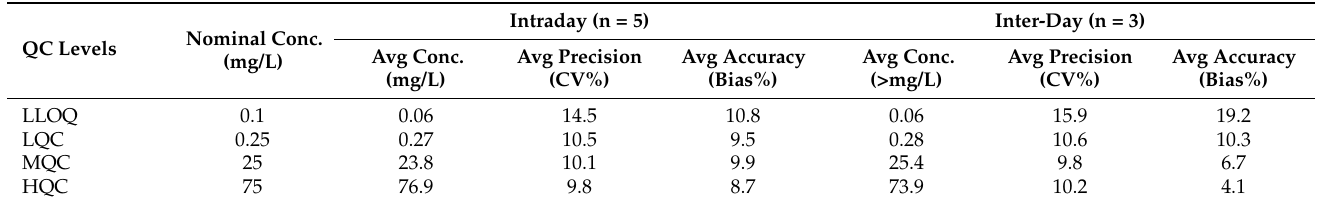
Table 3. Intra-day and inter-day average (avg) precision and accuracy assessed at four concentration levels (LLOQ, LQC, MQC and HQC) five times (intra-day) in three different analytical runs (inter-day) for MRP.